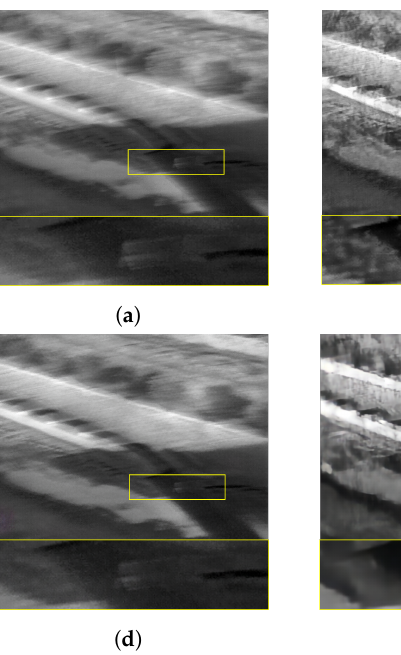
Figure 21. Qualitative comparison of motion deblurring results on the real blurry thermal image. ( a ) Real blurry thermal image acquired with a camera rotating at 100 ◦ / s , ( b ) SRN [33], ( c ) SIUN [36],